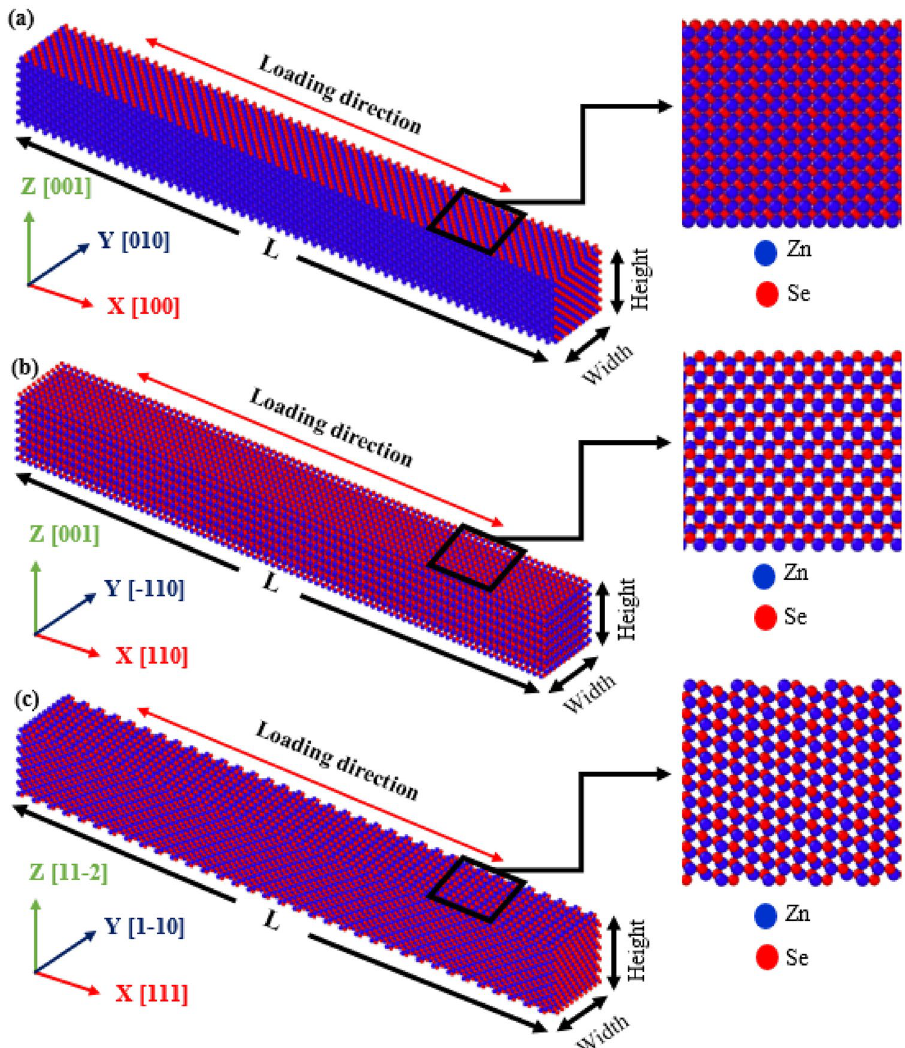
Figure 1. Initial structure of the ( a ) [100]-directed, ( b ) [110]-directed and ( c ) [111]-directed zinc-blende ZnSe NW with a dimension of ~ 34 nm × 3.97 nm × 3.97 nm. The cross-sectional area of all the NWS models is ~ 15.76 nm 2